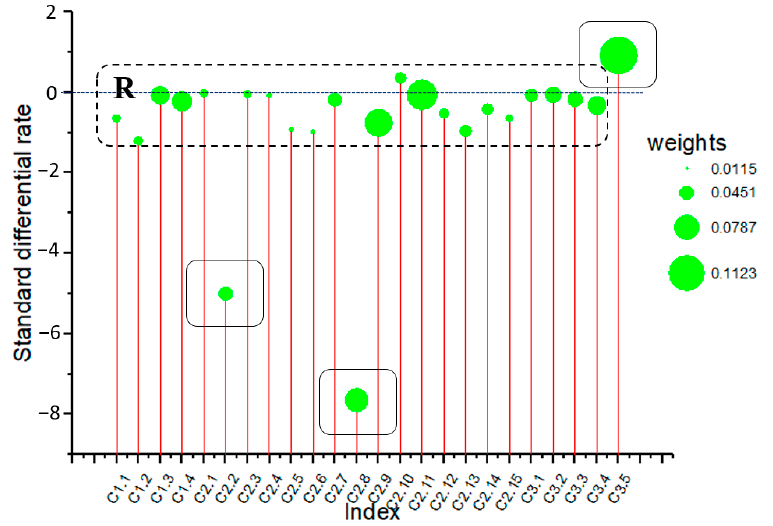
Figure 4. Weight distribution diagram of the standard difference rate.